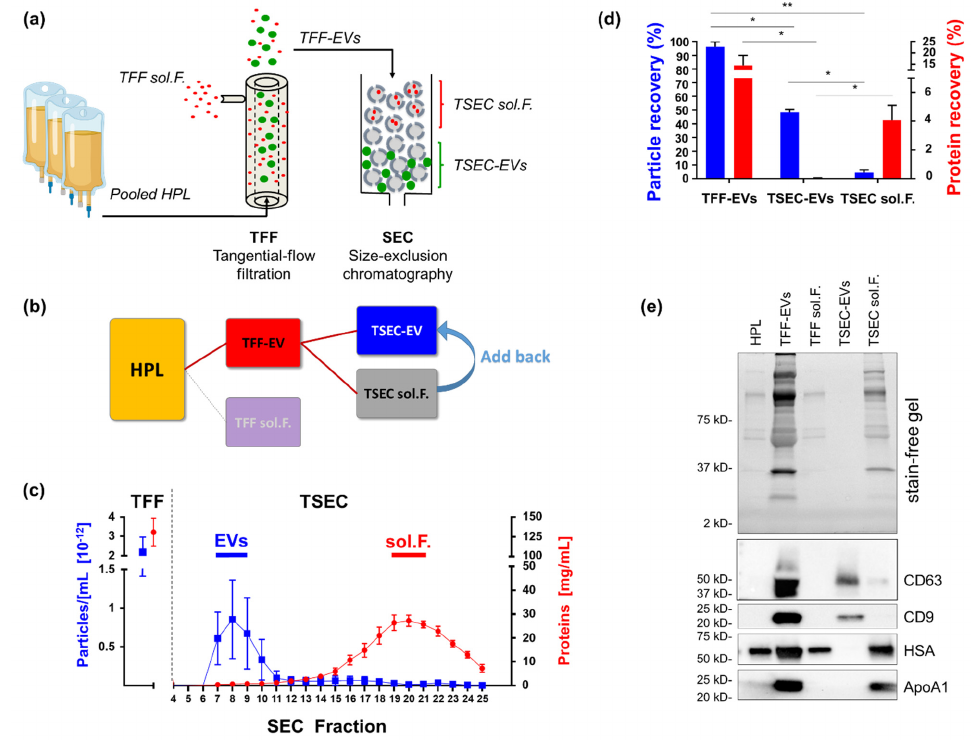
Figure 1. Purification and characterization of human platelet lysate-derived extracellular vesicles (HPL EVs). ( a ) Schematic illustration of EV purification from pooled HPL created using biorender. After two freeze-thaw cycles of expired platelet concentrates and pooling, HPL supernatant was diluted 1:10 in cell culture medium and then separated into soluble factors (sol.F.) and enriched EVs by tangential flow filtration (TFF) [24]. For further enrichment, TFF-EVs were separated by size exclusion chromatography (SEC) into EV (TSEC-EV) and lipid/protein-enriched TSEC-soluble fractions. ( b ) Wire graph illustrating HPL fractionation and the three main fractions analyzed through- out the study. ( c ) Monitoring of protein separation from particles by TFF and subsequent SEC, re- spectively. Particle concentration measured by tunable resistive pulse sensing (TRPS; blue squares and blue line). Protein concentration analyzed by detergent-compatible (DC) protein assay (red cir- cles and red line). Mean ± SD of three independent experiments performed in triplicate. ( d ) Com- parison of particle and protein recovery after EV purification by TFF and TSEC showed particle recovery of 96.13 ± 3.87%, 48.35 ± 2.05% and 4.45 ± 2.05% for TFF-EVs, TSEC-EVs and TSEC-soluble fractions, respectively. Protein recovery was 14.86 ± 6.99%, 0.06 ± 0.003% and 4.12 ± 1.59% for TFF- EVs, TSEC-EVs and TSEC-soluble fractions, respectively. Two-way ANOVA/repeated measures, ** p ≤ 0.01, * p ≤ 0.05. ( e ) Western blot for tetraspanins CD63 and CD9, human serum albumin (HSA) and apolipoprotein A1 (ApoA1). Representative depiction, two independent western blot experi- ments were performed.